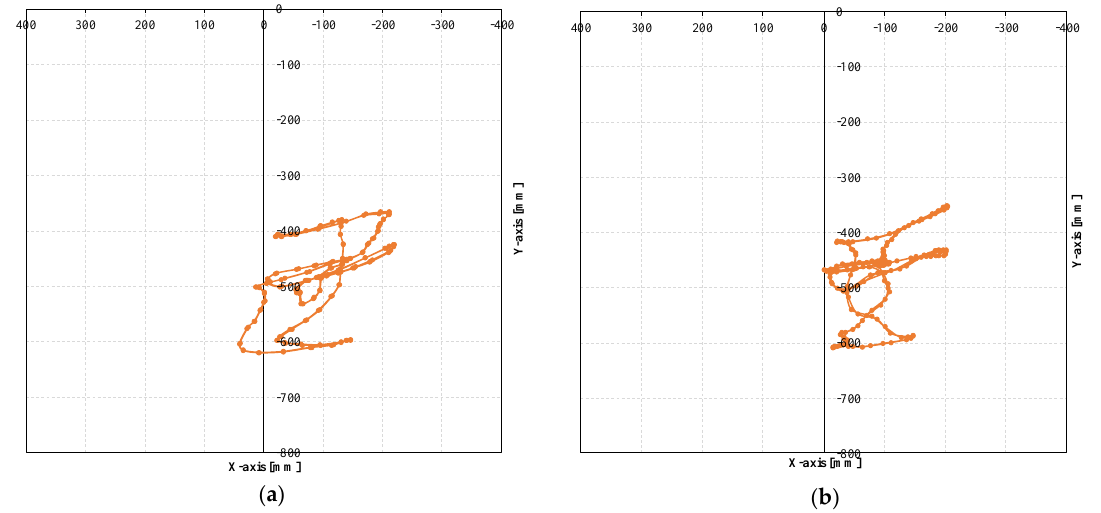
Figure 20. Trajectory of the leg tip using evaluation function 3 with 0.5 kg (( a ) first generation, ( b ) 18th generation).